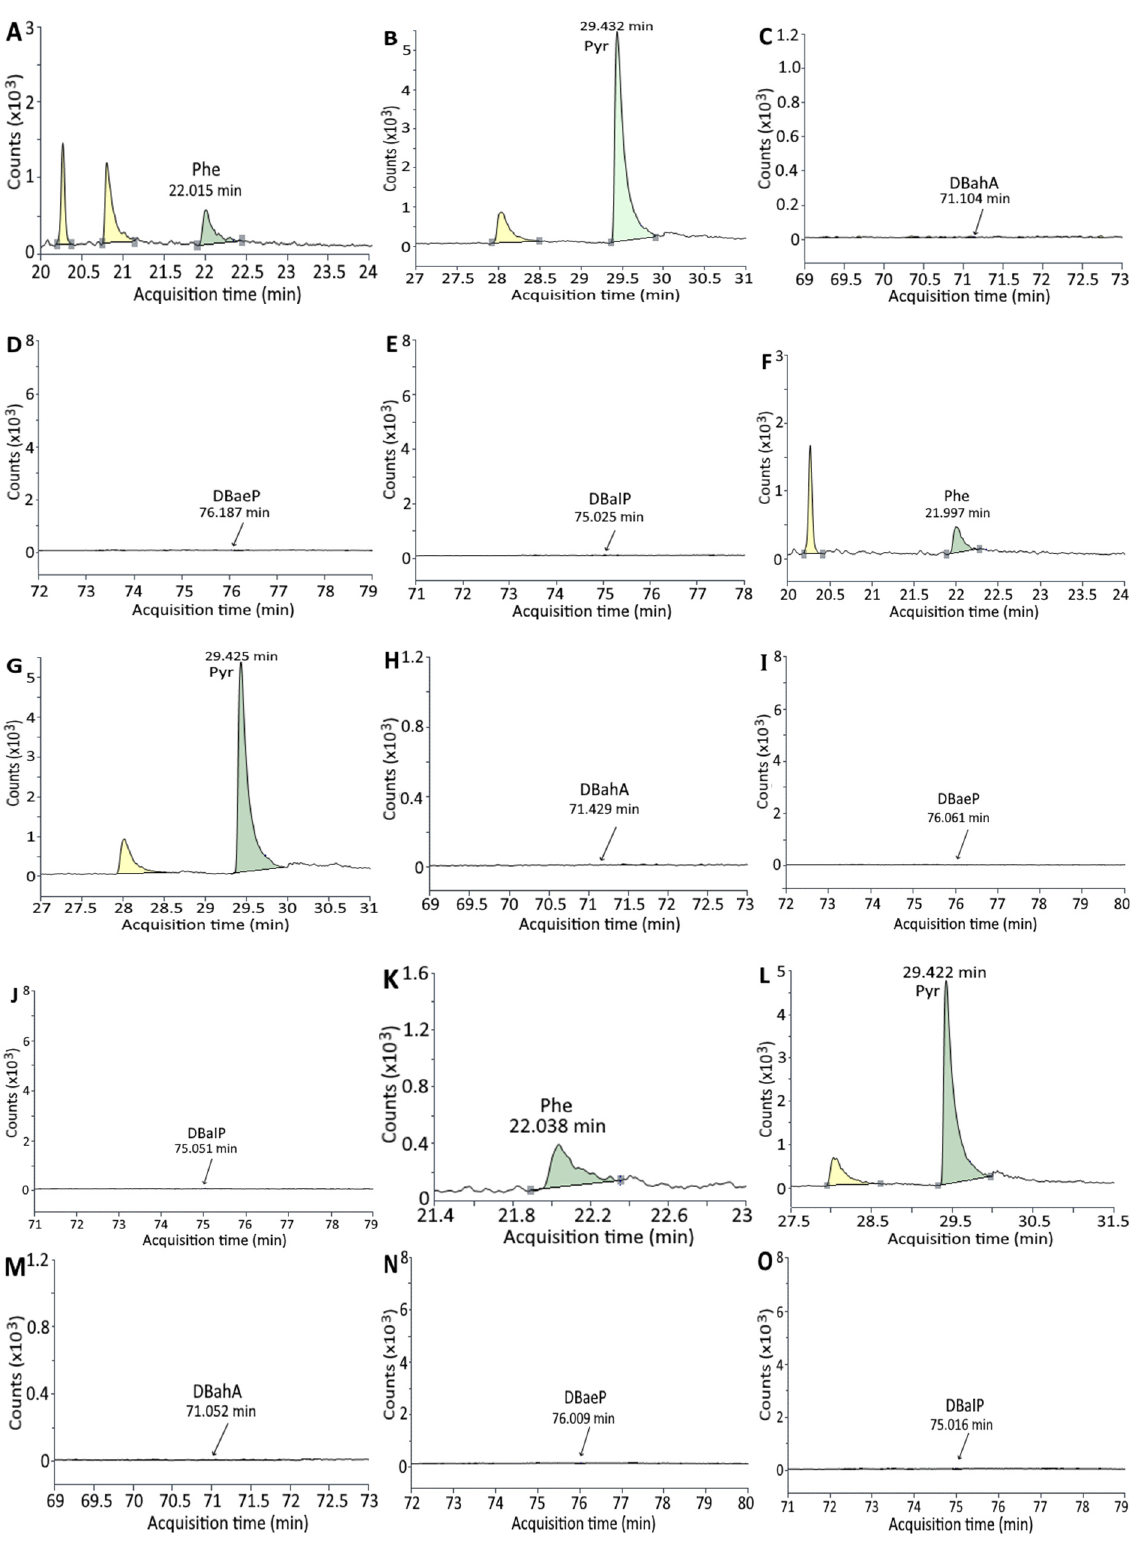
Figure 4. GC-MS/MS chromatogram of PAHs in marinated juice after 24 h marinating ( A – E ), marinated juice with 0.5% cinnamon powder after 24 h marinating ( F – J ) and marinated juice with 0.5% green tea powder after 24 h marinating ( K – O ), as detected by SRM mode. ( A , F , K ): Phe; ( B , G , L ): Pyr; ( C , H , M ): DBahA; ( D , I , N ): DBaeP; ( E , J , O ):